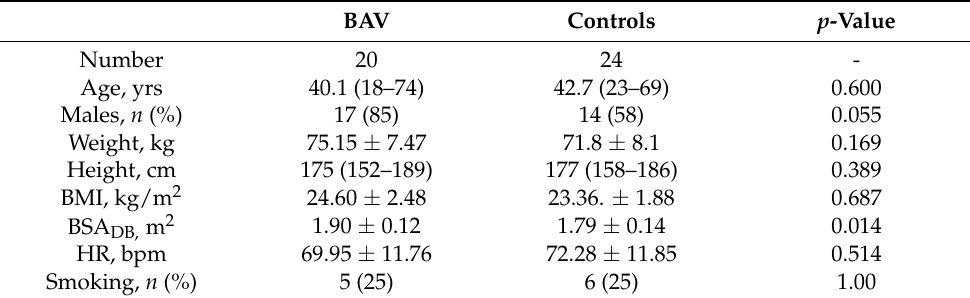
Table 1. Baseline characteristics of the study population: cases vs. controls. BAV Controls p